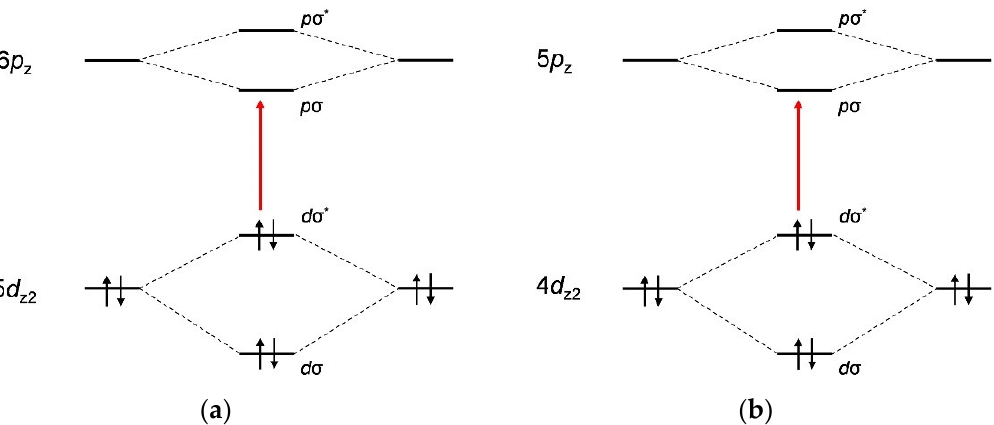
Figure 7. UV-visible spectra of hybrids of ( a ) [Au(CN) 2 ] − , ( b ) [Ag(CN) 2 ] − , and ( c ) [Pt(CN) 4 ] 2− with diblock copolypeptide amphiphiles 1–3, where [Au(CN) 2 ] − = 3.5 mM, [Ag(CN) 2 ] − = 5.0 mM, and [Pt(CN) 4 ] 2− = 2.7 mM. ( d – f ) Spectra enlarged to show region from 230 to 350 nm to focus on metal-metal interactions.